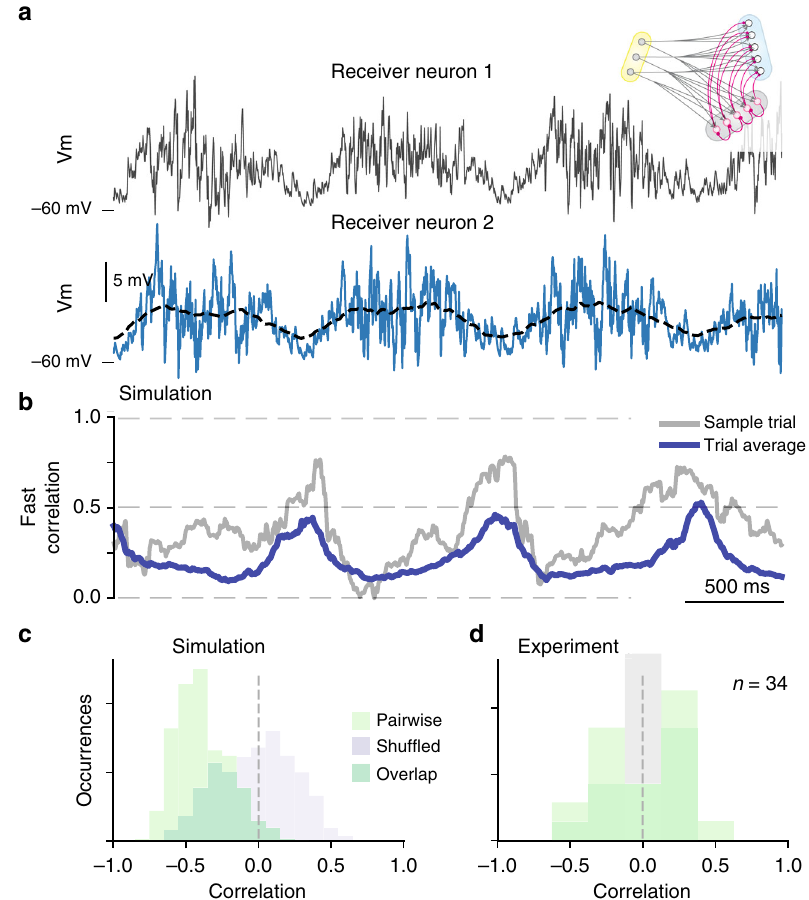
Fig. 10 Active decorrelation is dependent on the fi ring rate. a Membrane potential ( V m ) of two simulated sample neurons (gray and blue) for 3 cycles of motor behavior in a recurrent topology model (inset). The dashed line indicates low – pass fi ltered V m used for correlation analysis below. b Fast correlation between traces in a vs. time has a clear rhythm, i.e. dependence of fi ring rate. Sample pair (gray) and population average (blue). c Histogram of correlation between fast correlation and V m indicates anti – phase (negative correlation, green) compared with shuf fl ed data (gray). d No anti – phase relation between fast correlation and V m was apparent in experimental measurement (green, n = 17 pairs, 34 correlations) i.e. not signi fi cantly different from shuf fl ed distribution (gray, Kolmogorov Smirnov